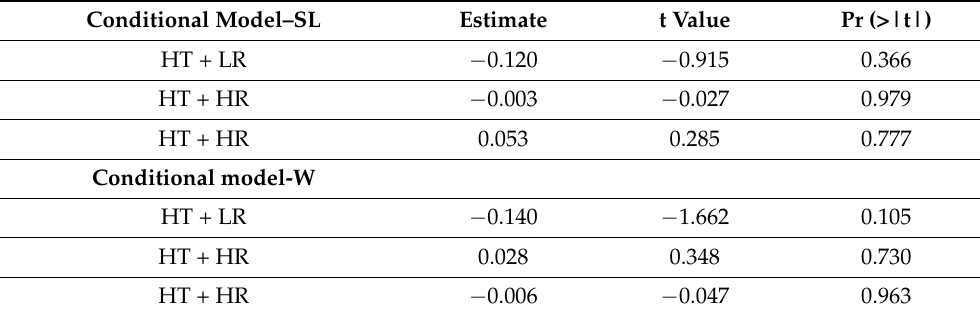
Table 4. Effect of temperature (CT, HT) and food availability (HR, LR) on two-spotted goby, Poma- tochistus flavescens size (SL) and weight (W) after one month in the